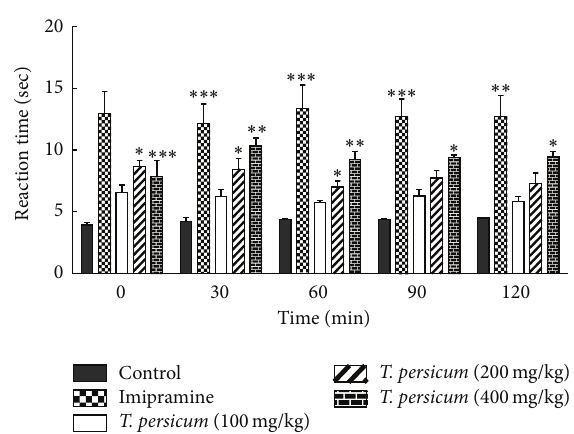
Figure 6: Latency response of the Teucrium persicum treated animals in comparison with the control and Imipramine treated animals.. ∗ 𝑃 < 0.05 , ∗∗ 𝑃 < 0.01 , and ∗∗∗ 𝑃 < 0.001 significantly differentfromthecontrolanimals.Eachvaluerepresentsthemean ± SEM ( 𝑛 = 8